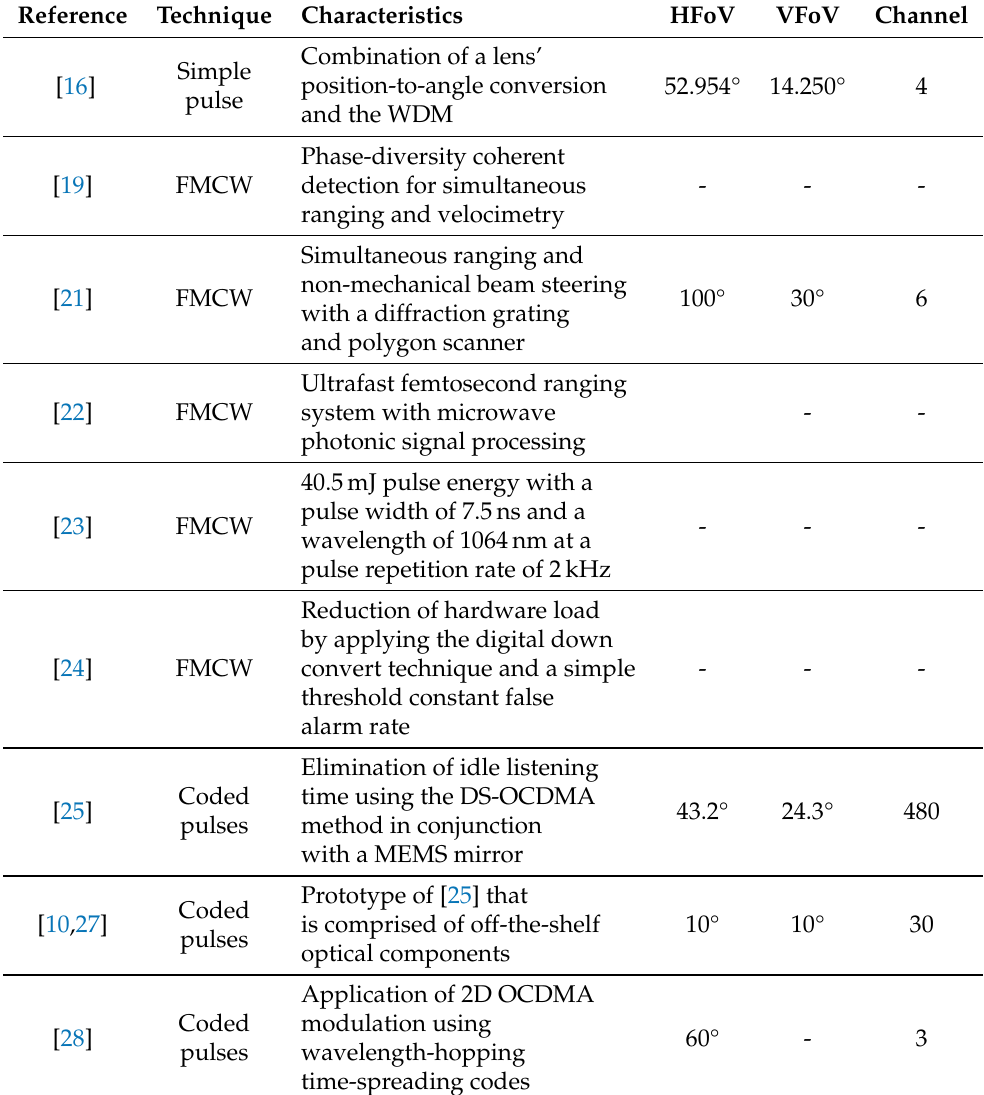
Table 1. Characteristics of state-of-the-art related